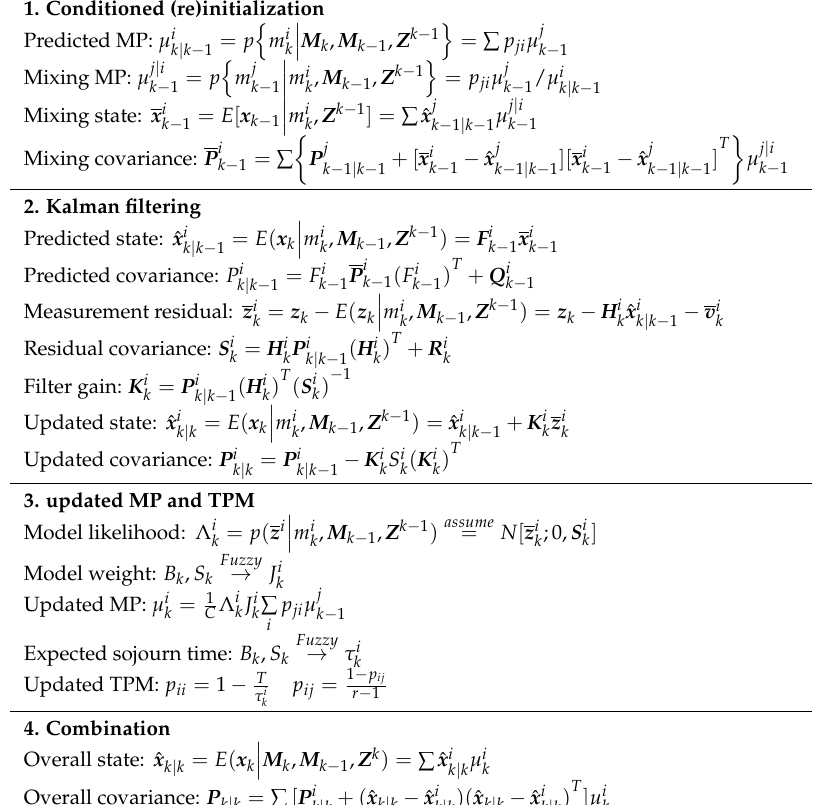
Table 1. The iterative process of the FOIA-MM algorithm.